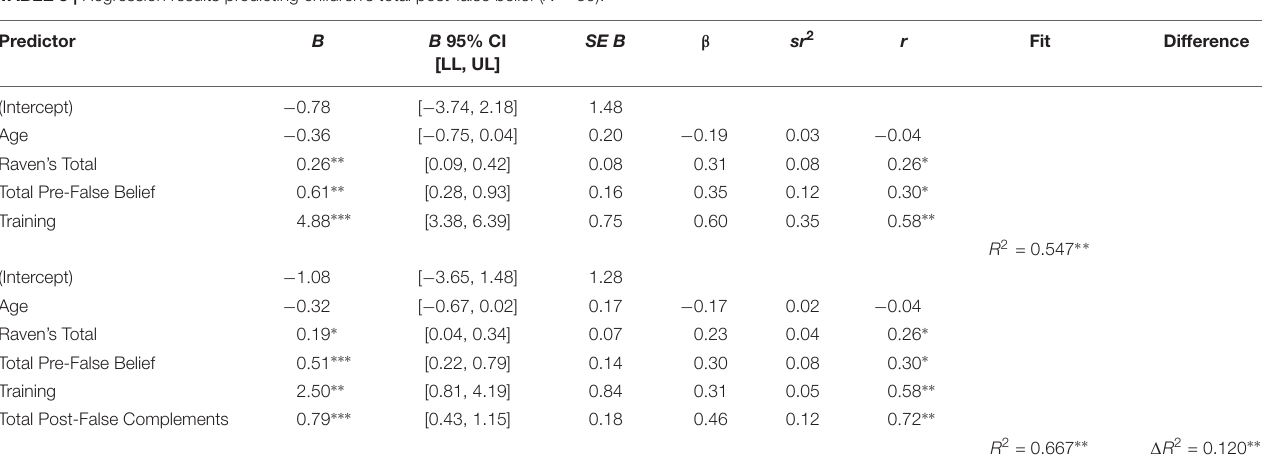
FIGURE 7 | Scores on verbal FB, low-verbal FB and false complements at the moment of pre-test, post-test, and follow-up. TABLE 3 | Regression results predicting children’s total post-false belief ( N =